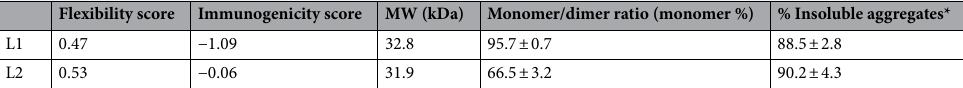
Table 1. Properties of L1 and L2 variants. *Percent insoluble aggregation was calculated by subtracting soluble protein concentration from total concentration after thermal (60 °C) and mechanical (220 rpm) stress for 4 h. The average of 3 different samples was